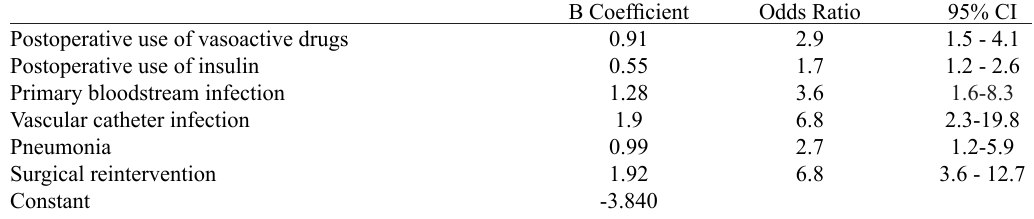
Table 7. Variables associated with the occurrence of surgical site infection in logistic regression analysis.